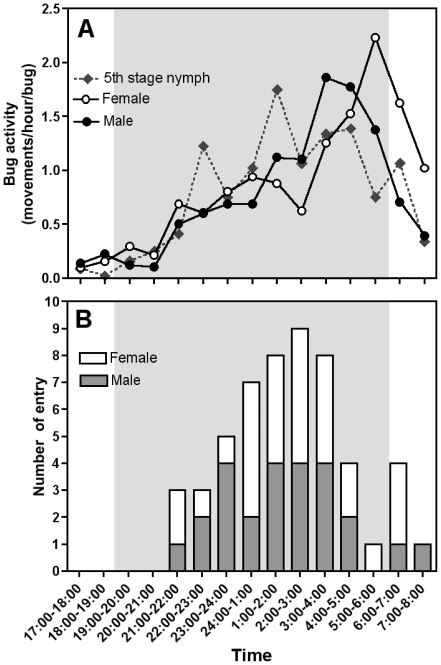
Activity pattern and light attraction of T. dimidiata during the night.(A) The number of individual movements per hour was determined from the analysis of the video recordings of adult males, females and 5th stage nymphs. (B) The time adult males (dark gray bar) and females (white bar) entered the tunnel with light was recorded. Shaded gray areas indicate the night period.